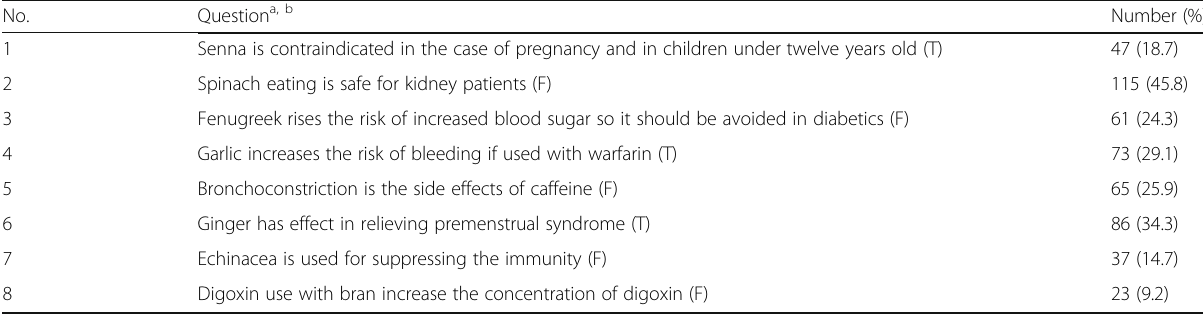
Table 2 Numbers and percentages of participants who answered correctly on the 8 knowledge questions No.